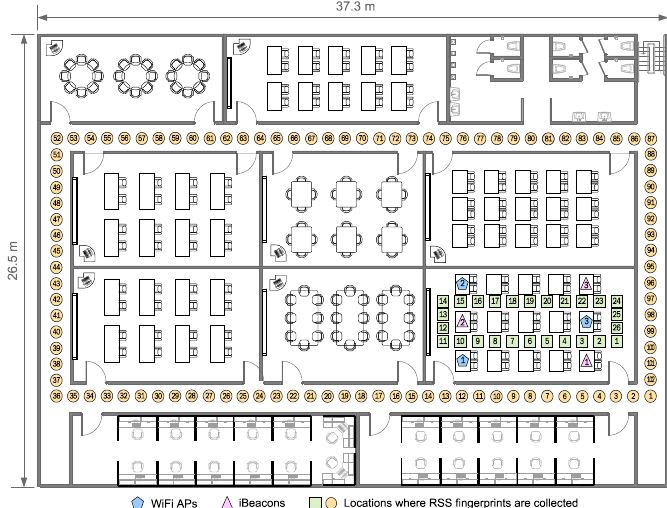
Figure 4. Floor map for experimental testbeds. RSS fingerprints and user’s direction information are collected in both the hallways and